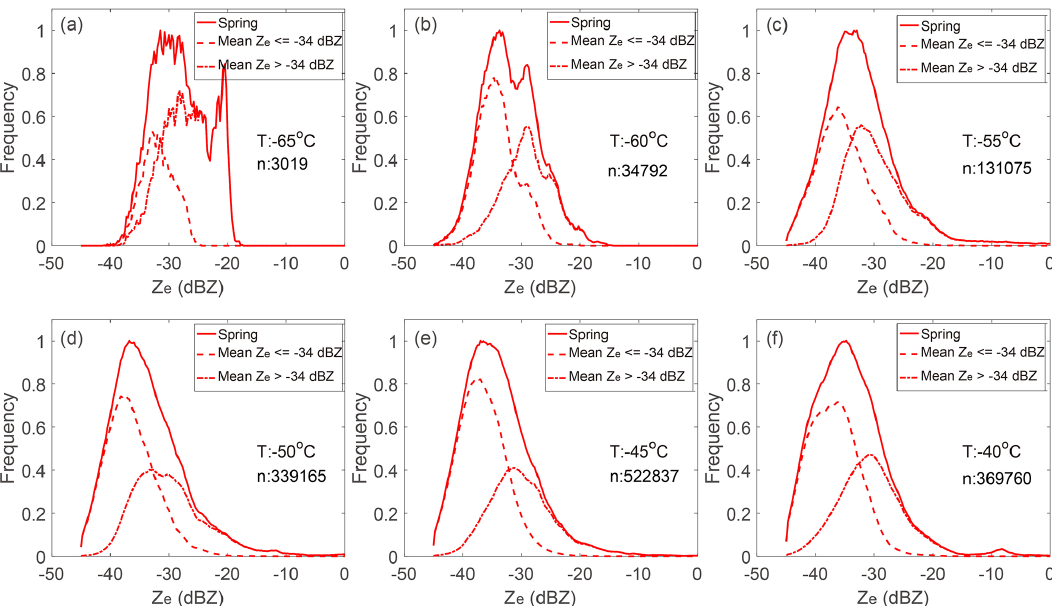
Figure 8. Normalized frequency of the reflectivity at different temperatures ( T ) in spring. The solid line is the frequency calculated from all cirrus clouds. The dashed line is the frequency calculated from cirrus clouds with a mean Z e < − 34dBZ. The dash-dotted line is the frequency calculated from cirrus clouds with a mean Z e above − 34dBZ. The dashed line corresponds to the in situ-origin type, and the dotted line corresponds to the liquid-origin type. n is the maximum number used to normalize the frequency.